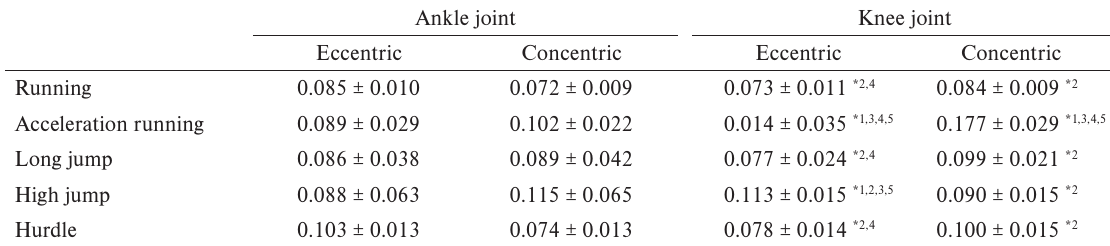
Eccentric and concentric phase durations (presented as mean ± SD in seconds) in ankle and knee joints